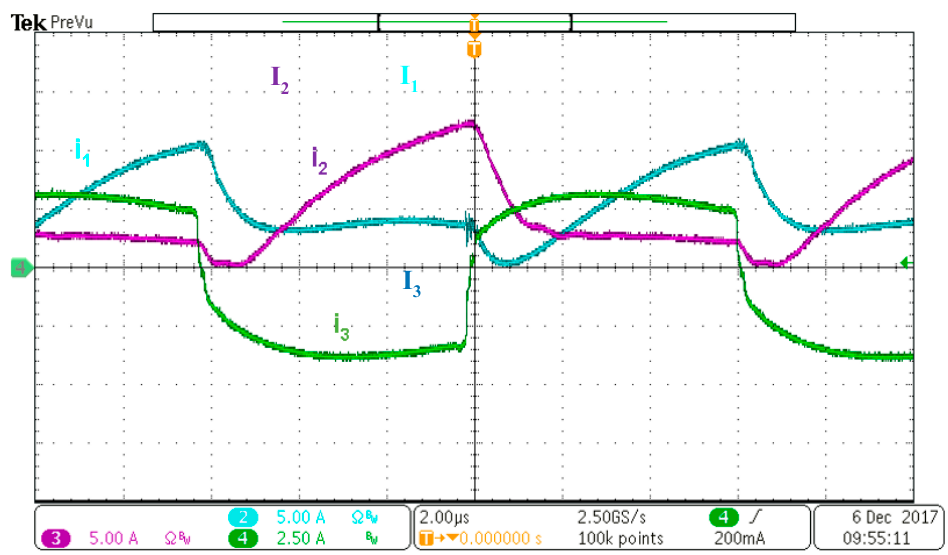
Figure 12. Current waveforms of the inductors L 1 – L 3 (100% of output power)—Measurement.